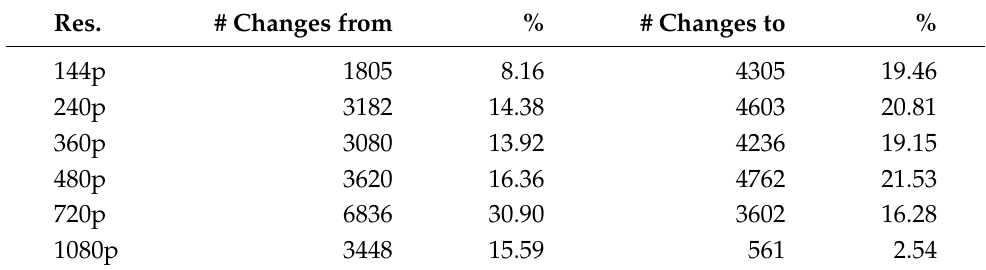
Table A1. Video quality change